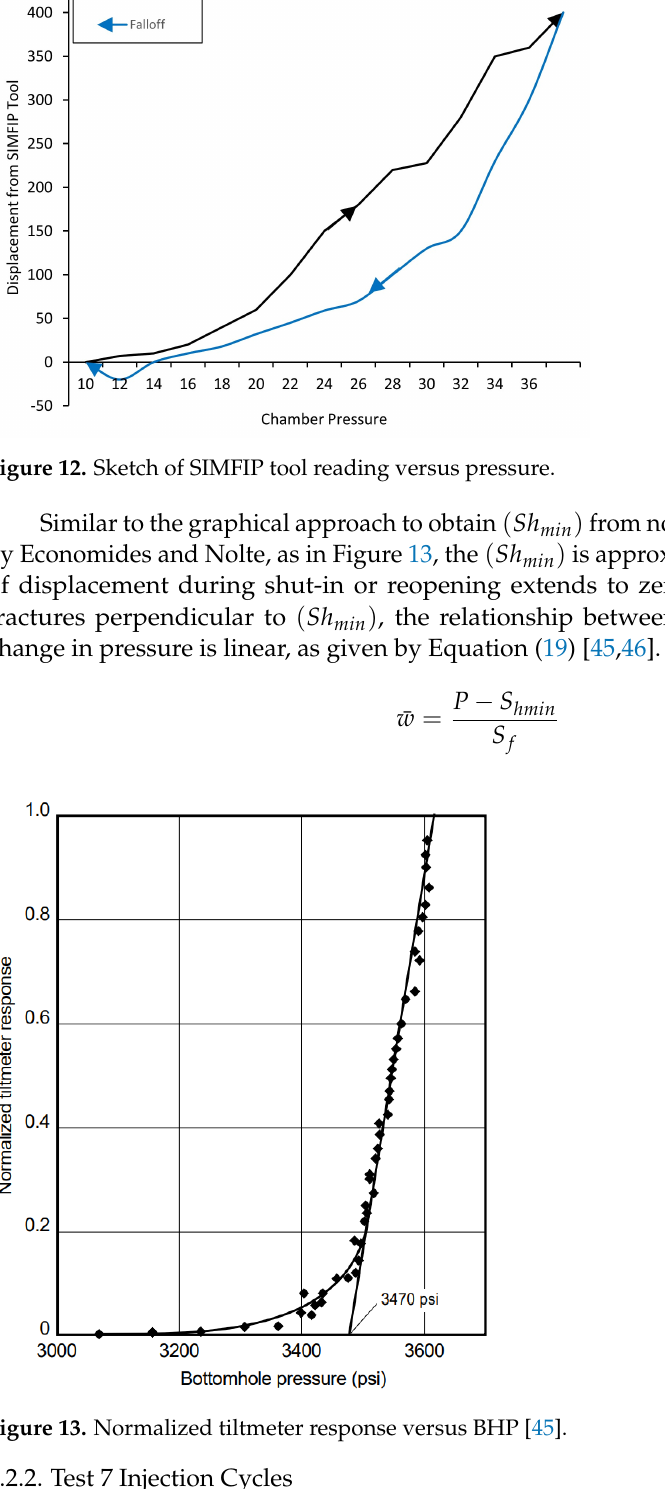
Figure 13. Normalized tiltmeter response versus BHP